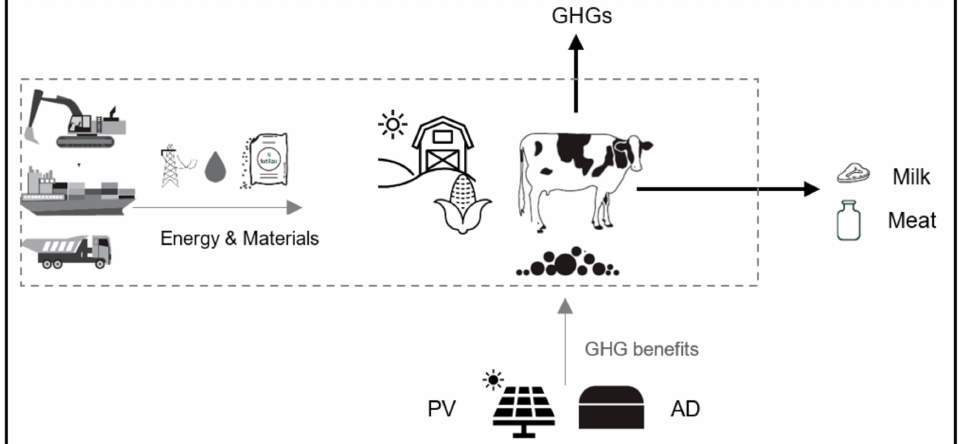
Figure 1. System boundaries of the study (solid lines). Dashed lines define the steps included at the small and large base-case dairy farms, where anaerobic digestion (AD) and solar PV systems were posteriorly added to evaluate the effects on environmental impacts.